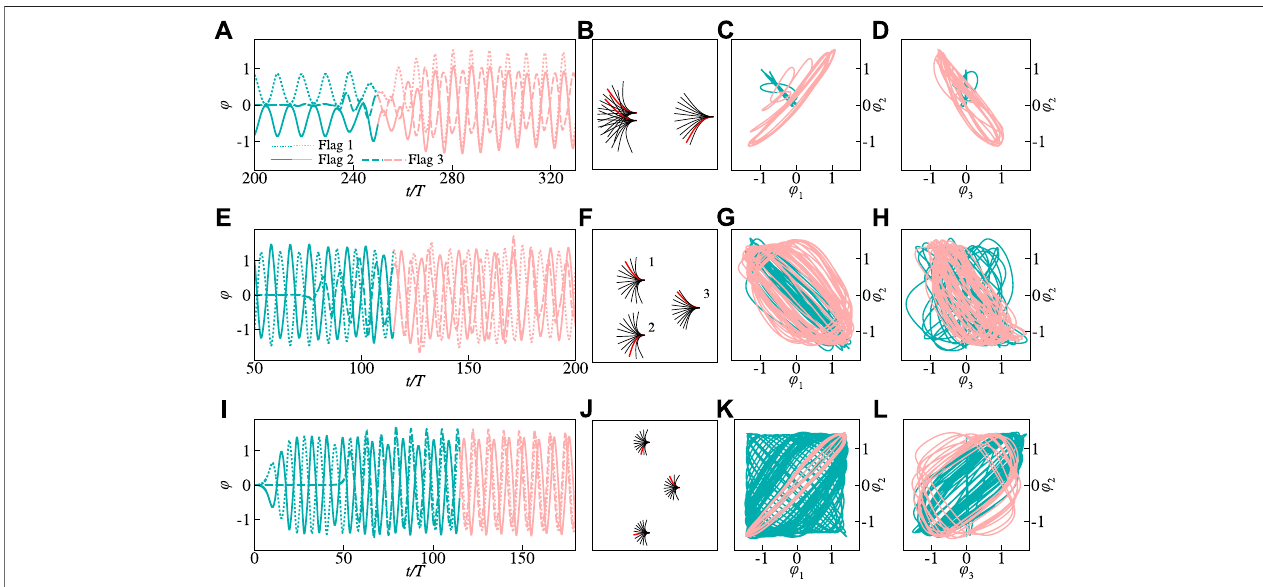
FIGURE 10 | Time history of the instantaneous fl apping angle ϕ (A,E,I) , the superimposed views of the fl ags (B,F,J) , and the phase trajectories in ϕ 1 − ϕ 2 plane (C,G,K) and ϕ 3 − ϕ 2 ( d , h , l )planefordistinctmodesinrighttrianglecon fi gurations,i.e.,theregular-coupled(RC)modewith G =1, H =0.2 (A,B,C,D) ,theirregular-coupled (IC)modewith G =1, H =2 (E,F,G,H) anddecoupled(DC)modewith G =1, H =6 (I,J,K,L) .Theothergoverningparametersareasfollows:Re=200, M =2.9, K =0.3and S =1,000. Flag 1 and 2 represent the front upper and lower fl ags, respecitvely; Flag 3 represents the rear fl ag. The red beams in the second column fi gures represent the instantaneous position of the fl ags at a certain instant. The phase diagrams have been colored to represent time, with the curve being initially green and shifting to red as time advances.